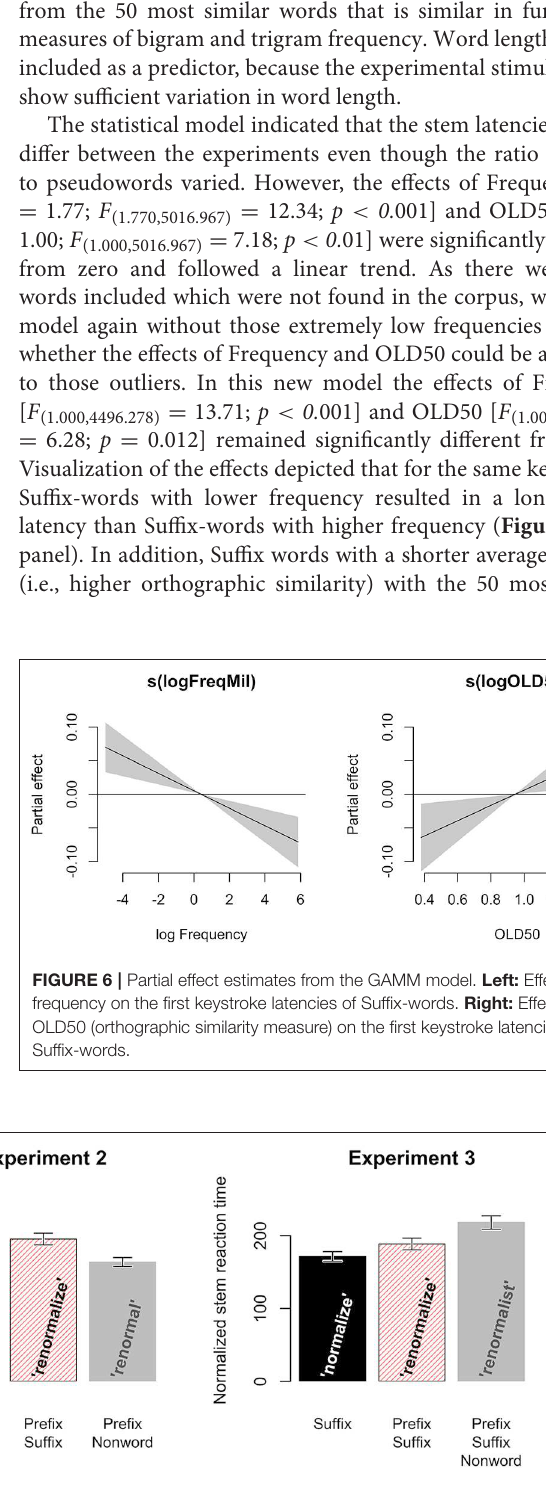
Frontiers in Communication |